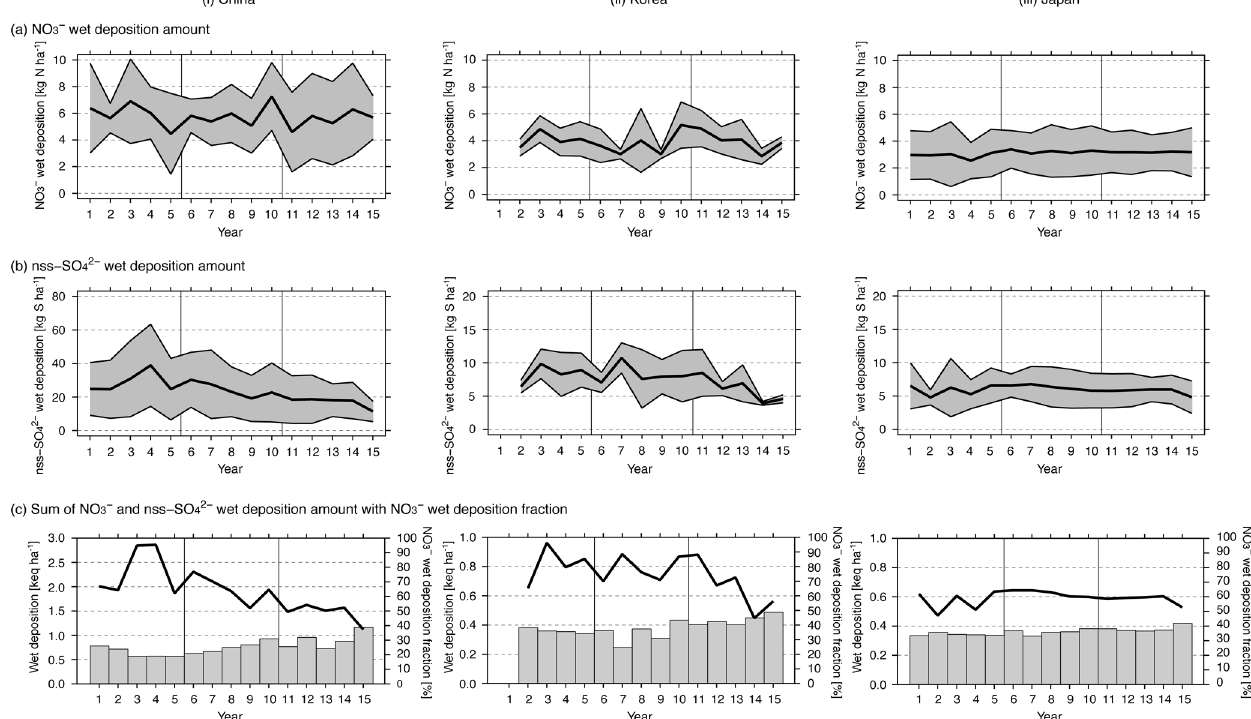
Figure 7. Long-term temporal variation in the (a) NO − wet deposition (kgNha − 1 ), (b) nss-SO 2 − wet deposition (kgSha − 1 ), and (c) sum 3 4 of NO − and nss-SO 2 − wet deposition (keqha − 1 ) with the NO − fraction during 2001–2015 over (i) China, (ii) Korea, and (iii) Japan. One 3 4 3 standard deviation across observation sites is indicated by the shaded area in (a, b) . The numbers at the bottom indicate the number of years after 2000 (e.g., 5 indicates 2005 and 10 indicates